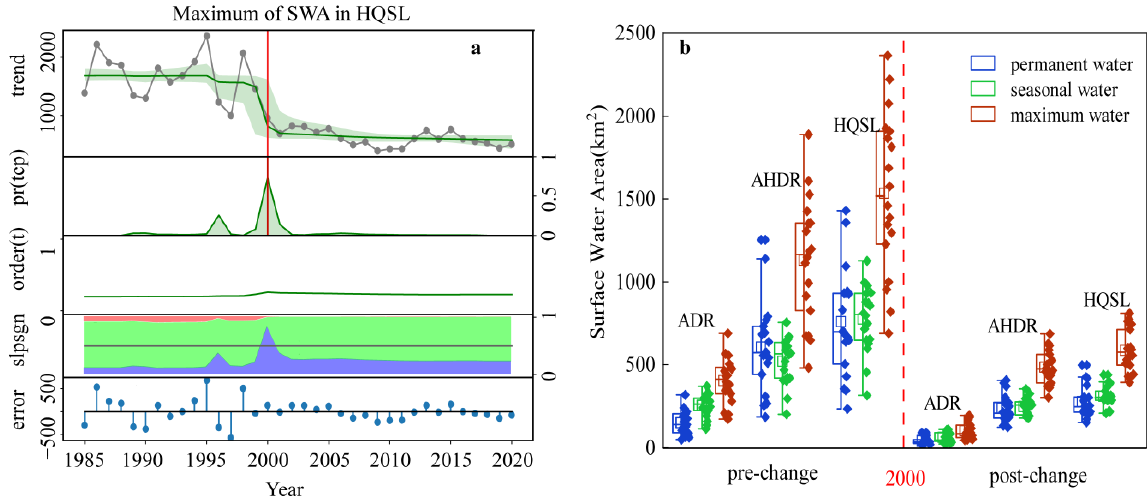
Figure 4. ( a ) Rbeast model result of SWA during the period 1985–2020 in HQSL. The left axis, trend: the SWA change, pr(tcp): the probability of change point occurrence, order(t): estimate to fit trend, slpsgn: probabilities of trend slope, error: abnormal remainders in the confidence interval of the abrupt change; ( b ) Box–Whisker plots of the permanent, seasonal, and maximum water areas with t -test significance level ( p < 0.01) between the pre-change period and the post-change period in ADR, AHDR, and HQSL.